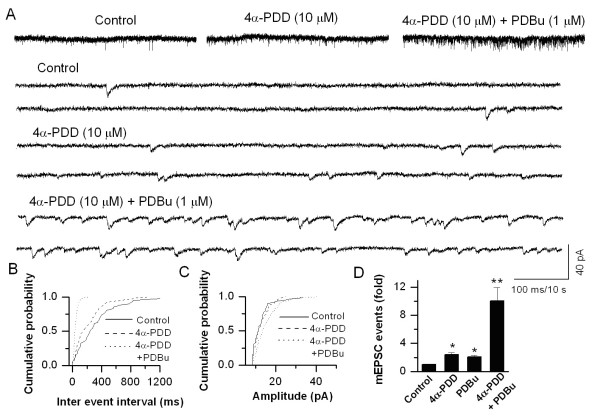
Enhancement of 4α-PDD-induced increase in synaptic transmission by PDBu in cultured hippocampal neurons. A. Application of 4α-PDD (10 μM) increases the frequency of mEPSCs, which is further potentiated by PDBu. The synaptic events are shown at a higher time resolution below. B. Cumulative probability plot shows a decrease in inter-event interval. C. The increase in frequency is not accompanied by a change in the amplitude. D. Summary graph showing 4α-PDD induces an increase in mEPSC frequency and this action is enhanced by PDBu (n = 7). The asterisk (*) represents P < 0.05 as compared to control; (**) represents P < 0.05 as compared to 4α-PDD group.